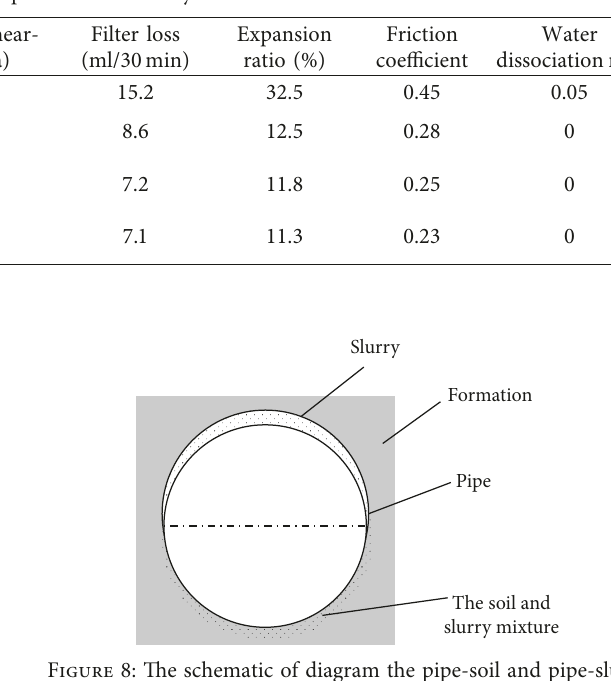
Table 1: The properties of the slurry.